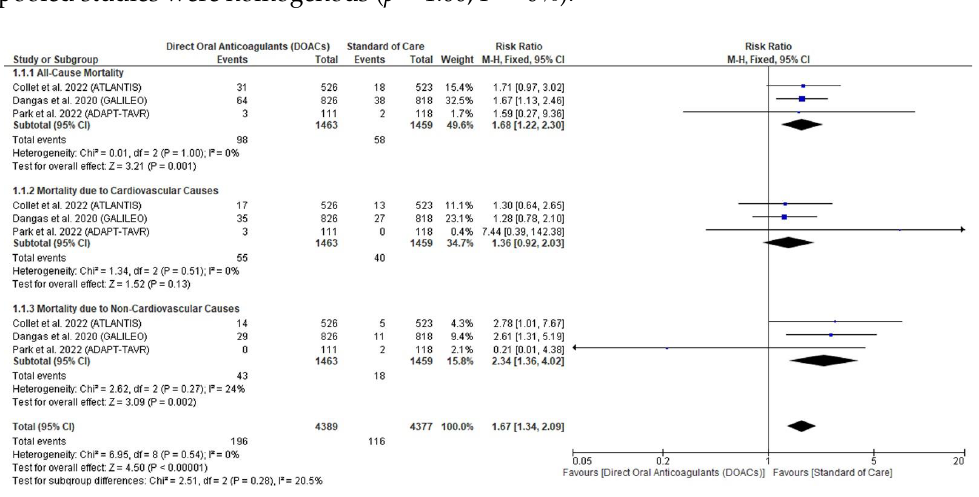
Figure 3. Forest plot of the primary outcome (Mortality). RR: risk ratio, CI: confidence interval [5,7,8].